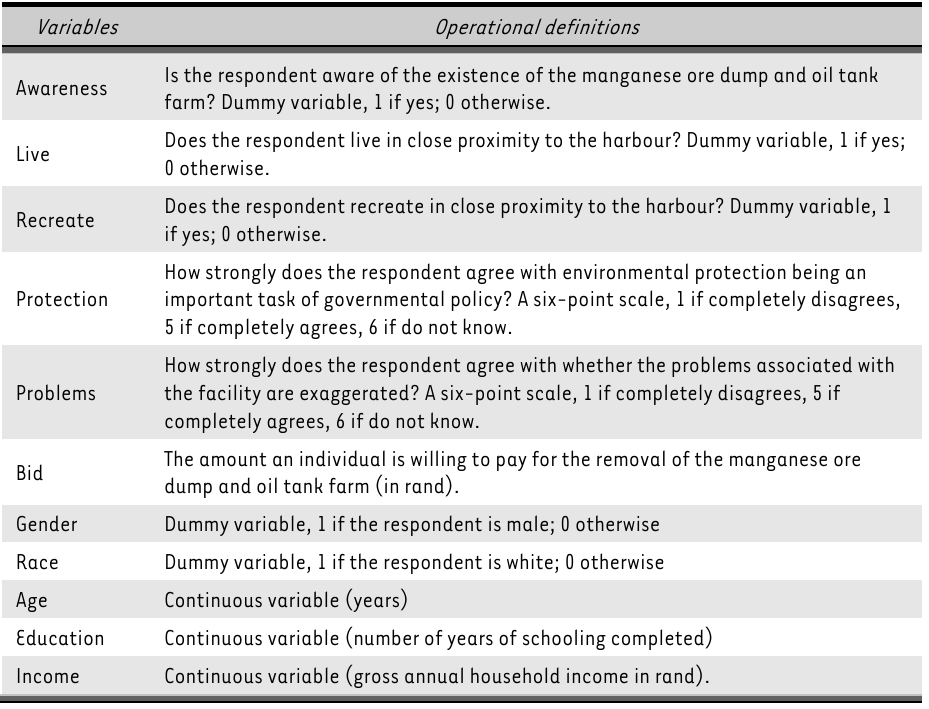
TABLE 5: Operational definitions of explanatory variables included in the logit model Variables Operational